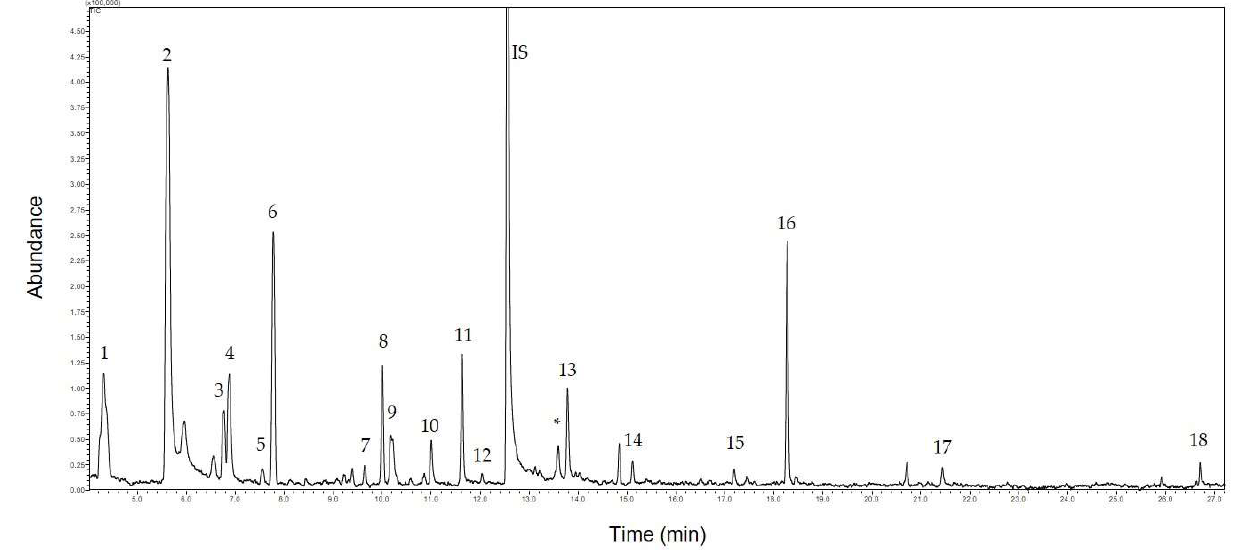
Figure 2. The chromatogram obtained during the analysis of the volatile organic compounds (VOCs) emitted by Fallopia baldschuanica . Abbreviation: *—unknown compound; IS—internal standard. The numbers in the chromatogram correspond to the numbers of the identified compounds in Table 1. Unnumbered signals are from the column filling (stationary phase) and/or from air pollution in the environment in which the flowers were packed into vials.